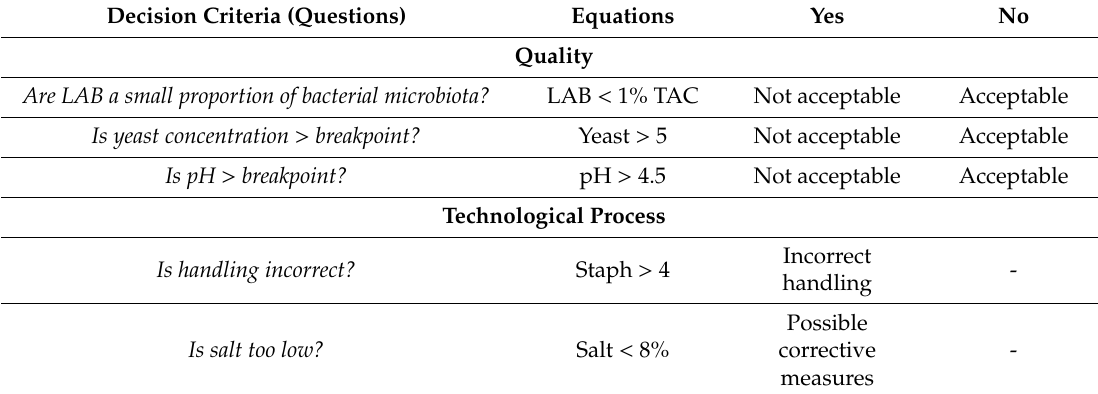
Table 1. Decision criteria for MoS (Micro-Olive-Spreadsheet) and respective equations and outcomes. Decision Criteria (Questions) Equations Yes No